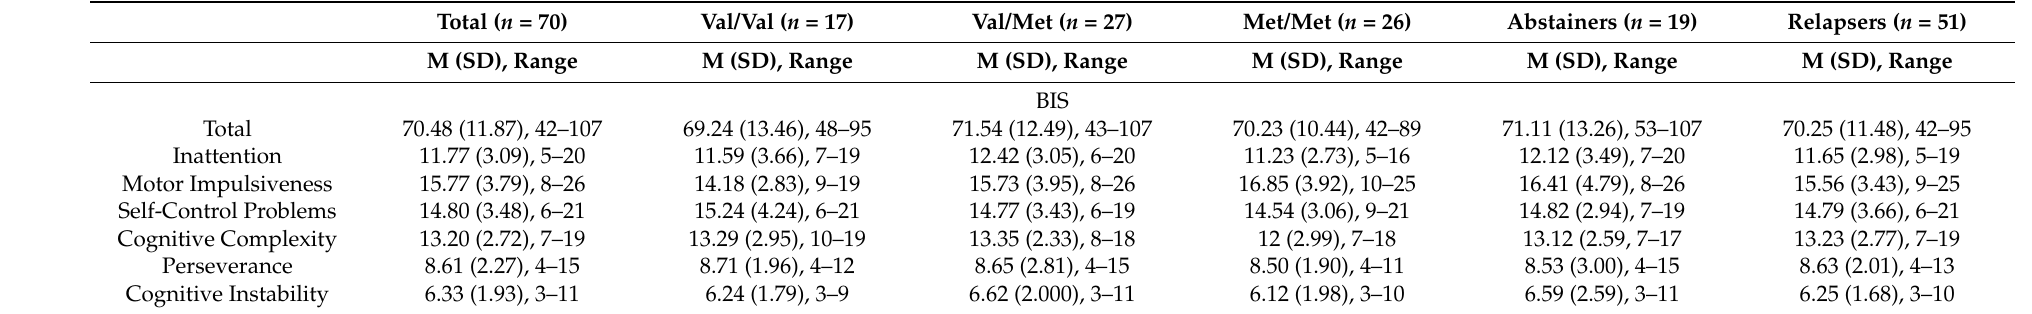
Table 5. Barratt Impulsivity Scale (BIS) by genotype and relapse